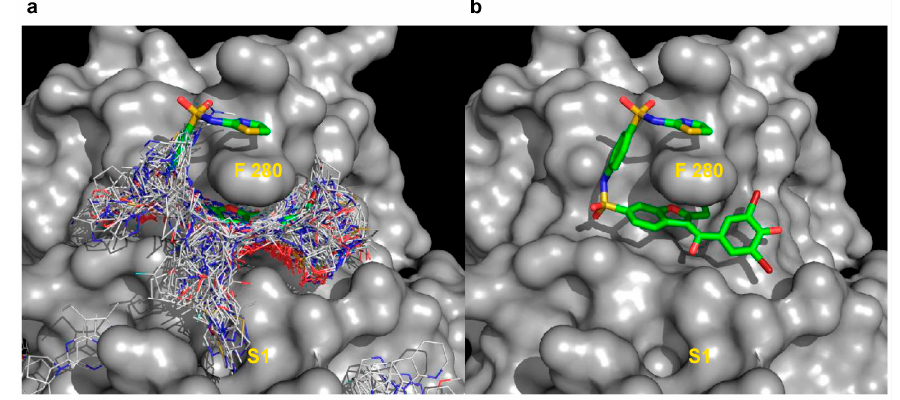
Figure 3. Compound cluster distribution at the allosteric site. Ligand cluster at the allosteric site. (4) partially overlaps with the binding site of BZ3 inhibitor reported in the literature [27]. ( a ) Overlay of the cluster at site 4 with compounds shown as lines on top of the allosteric inhibitor BZ3 (shown in green as sticks) and PTP1B as grey surface; ( b ) Crystal structure of BZ3 in complex with PTP1B. SAR during development of BZ3 was undertaken to optimise binding around F280 [27]. S1 represents a new sub-pocket identified in the screen with VSpipe that could be exploited to generate new allosteric inhibitors.